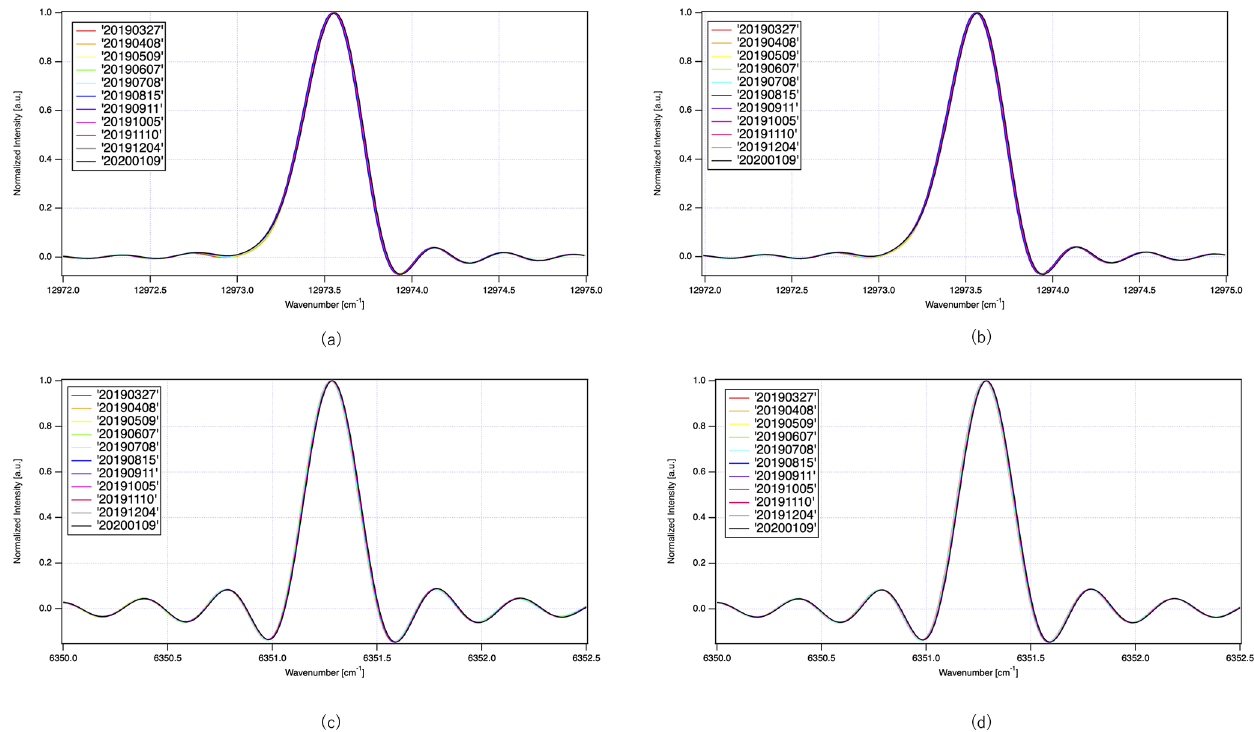
Figure 17. In-orbit instrument line shape functions: (a) band 1 p , (b) band 1 s , (c) band 2 p , and (d) band 2 s .